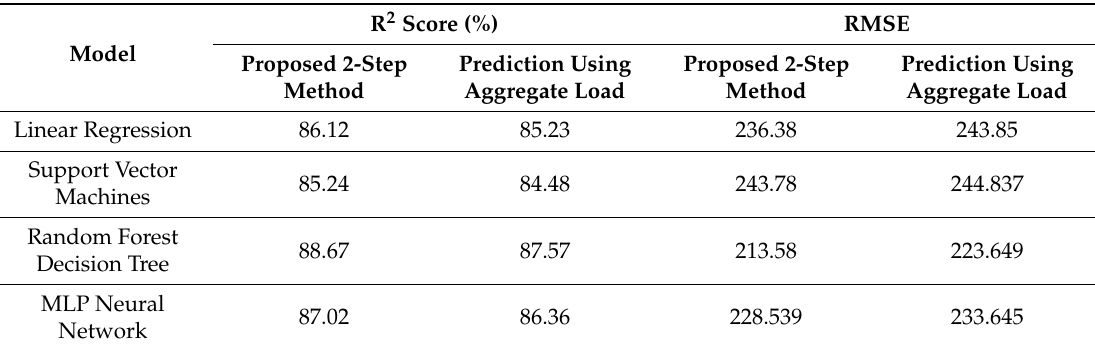
Table 7. Comparison of hour-ahead aggregate load prediction through the proposed 2-step method (which includes disaggregation) and prediction only using the aggregate load.